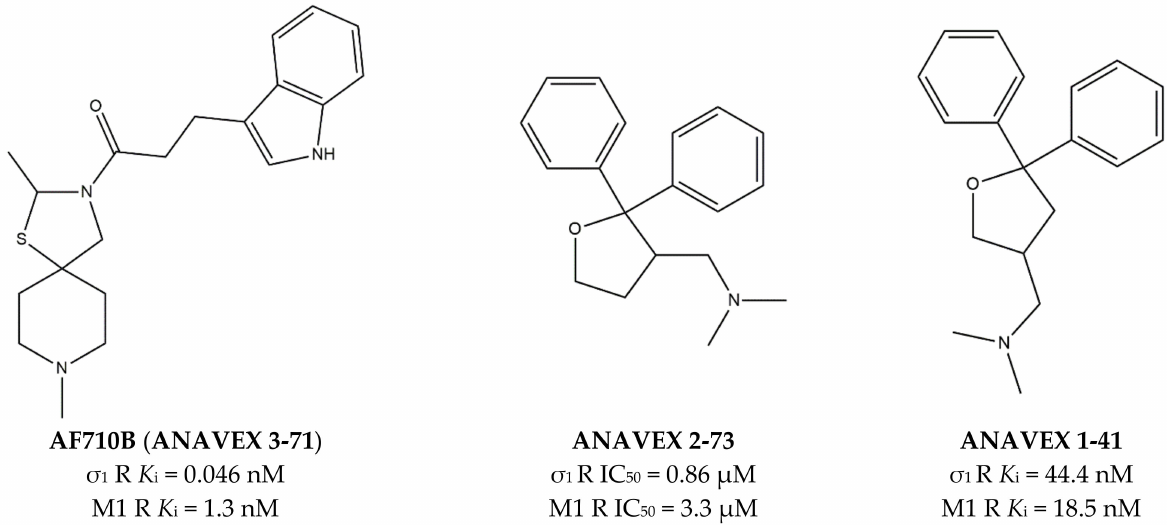
Figure 2. ANAVEX 3-71 , 2-73 and 1-41 structures and their K i and IC 50 values for σ 1 receptor ( σ 1 R) and muscarinic M1 receptor (M1 R)